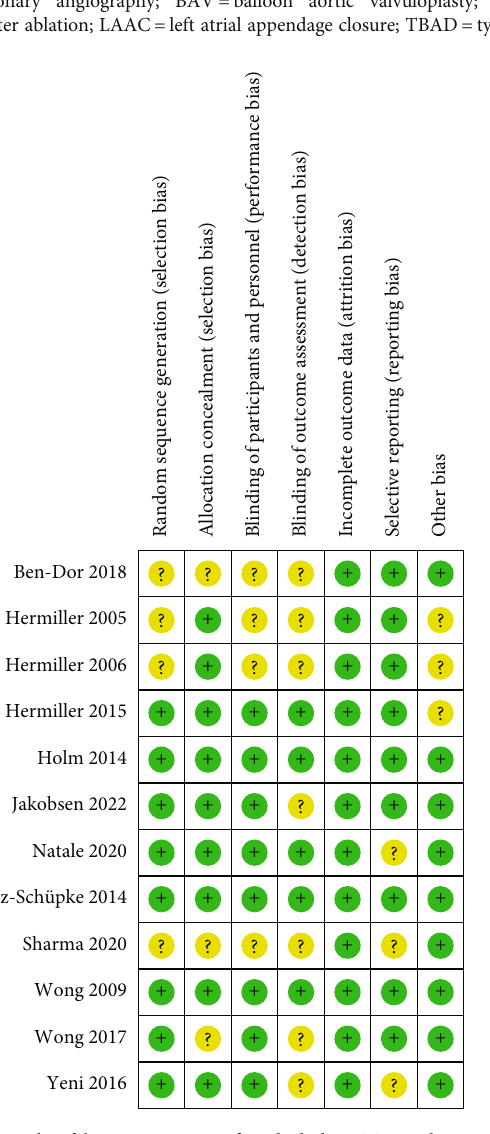
Figure 2: Risk of bias summary of included RCTs in the meta- analysis.